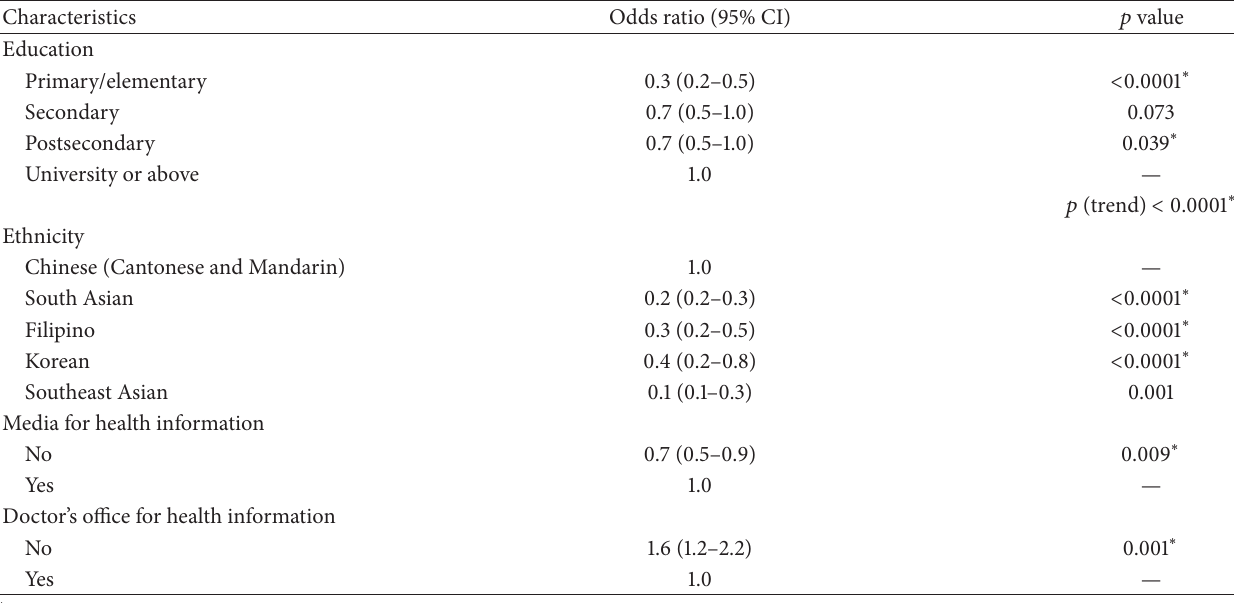
Table 5: Predictors of knowledge that HBV may cause cirrhosis from multivariate